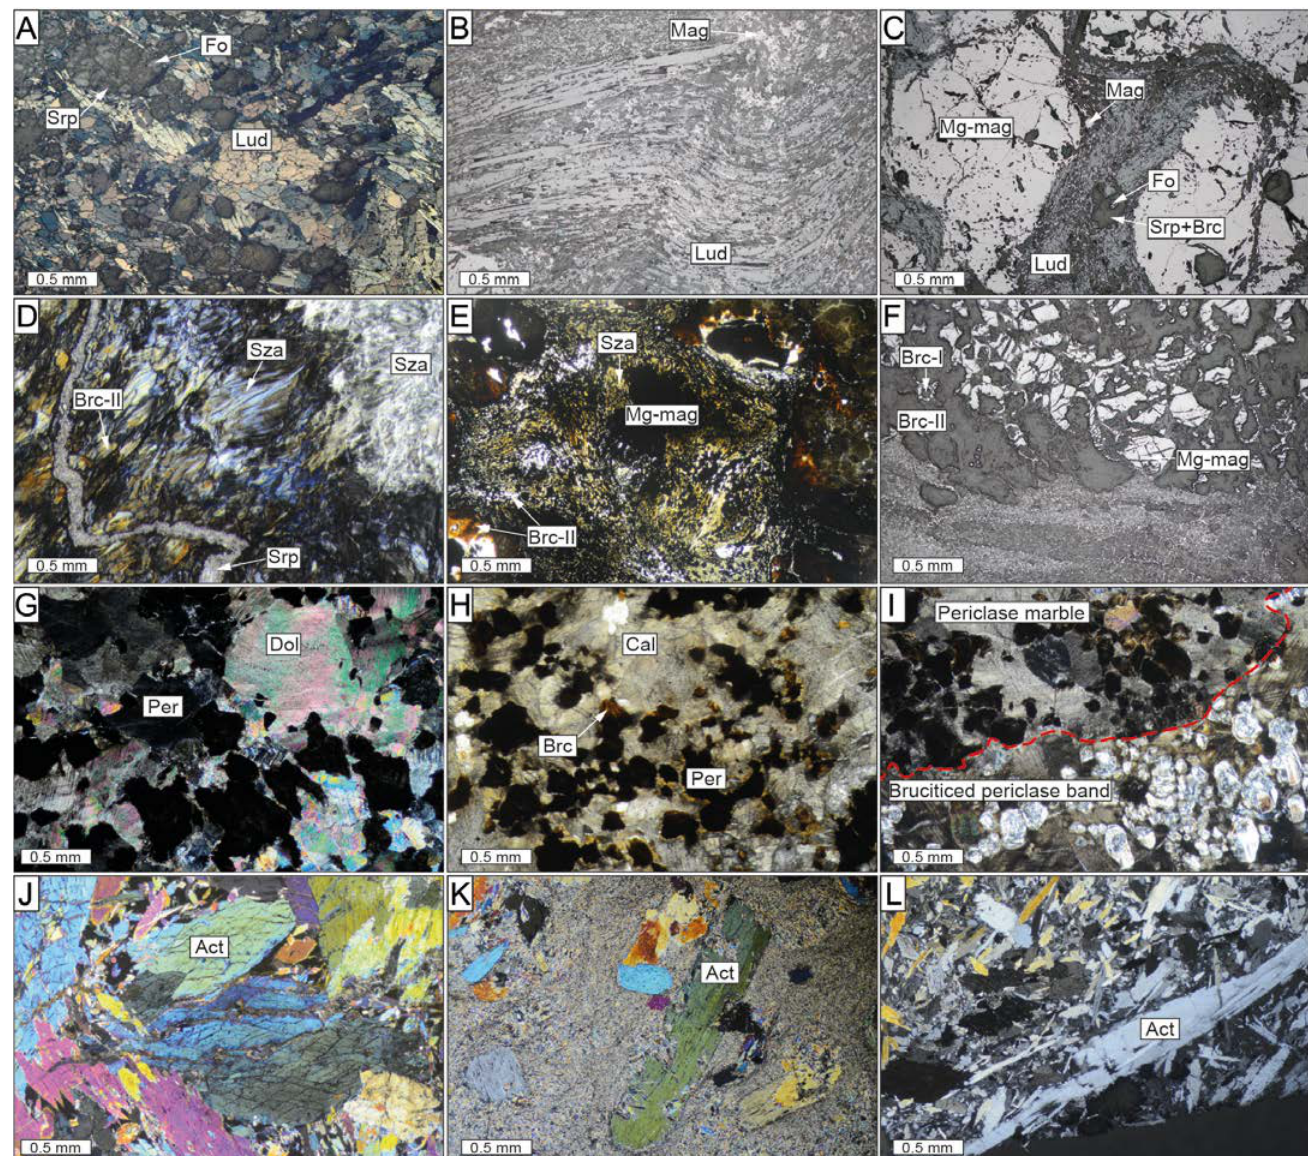
Figure 4. Transmitted light and reflected light microscopy photomicrographs of the El Robledal deposit. The microphotographs are arranged from the top (ludwigite–magnetite zone) to the bottom (magnetite–szaibelyite zone) of the mineralized area. ( A ) Massive ludwigite with interstitial forsterite. ( B ) Ductile deformed ludwigite crystals. ( C ) Cataclasized ludwigite filling fractures among granoblastic Mg-rich magnetite hosting partially serpentinized forsterite. ( D ) Fibrous-like, brucite-II and szaibelyite intergrowths from the magnetite–szaibelyite zone crosscut by a late serpentine vein. ( E ) Brucite-II and szaibelyite intergrowths around Mg-rich magnetite crystal. The dusty-brown rims around the Mg-rich magnetite are brucite-II crystals. ( F ) Mg-rich magnetite with brucitized cores. ( G , H ) Partially brucitized periclase marble in a nonmineralized area. ( I ) Irregular brucit- ized periclase bands crosscut periclase marble. The red-dashed line separates the periclase marble band from the brucite-rich band after periclase hydration. ( J ) Granoblastic aggregate of subhedral tremolite–actinolite grains from the reaction zone. ( K , L ) Porphyroclastic amphibolite with large actinolite grains partially replaced by a second generation of fibrous amphibole. Act: actinolite; Brc: brucite; Cal: calcite; Fo: forsterite; Lud: ludwigite; Mg-mag: Mg-rich magnetite; Mag: magnetite; Per: periclase; Srp: serpentine; Sza: